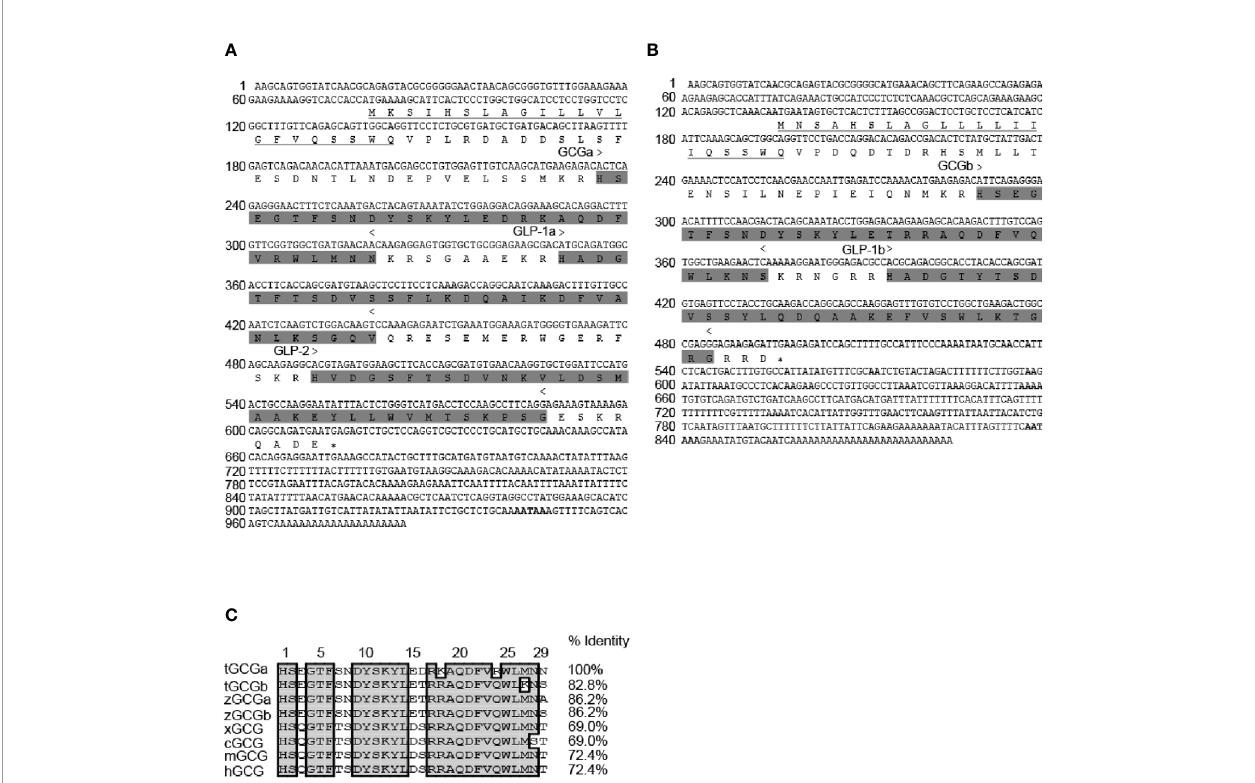
FIGURE 1 | Molecular cloning and sequence alignment of tilapia Gcga and Gcgb . Nucleotide and deduced amino acid sequences of tilapia (A) Gcga and (B) Gcgb . In the amino acid sequence, the putative signal peptides are underlined. GCGs, GLP-1s, and GLP-2 peptides regions are shaded and indicated > to <, and the polyadenylation signal is in bold. An asterisk (*) represents the stop codon. (C) Alignment of tilapia GCGs amino acid sequences with the corresponding GCG sequences reported in zebra fi sh (zGCGa and zGCGb), Xenopus (xGCG), chicken (cGCG), mouse (mGCG), and human (hGCG). Sequence alignment was using the Clustal W algorithm with DNAMAN software. The conserved amino acid residues in these sequences were boxed in gray. The sequences of Gcgs for other species were downloaded from the GenBank and/or by searching Ensembl genomes. GenBank accession numbers are as follows: tilapia GCGa (tGCGa, MT488303), tilapia GCGb (tGCGb, MT488304), zebra fi sh GCGa (zGCGa, NP001008595), zebra fi sh GCGb (zGCGb, NP001229699), Xenopus GCG (xGCG, NP001079787), chicken GCG (cGCG, NP990591), mouse GCG (mGCG, NP032126), and human GCG (hGCG,